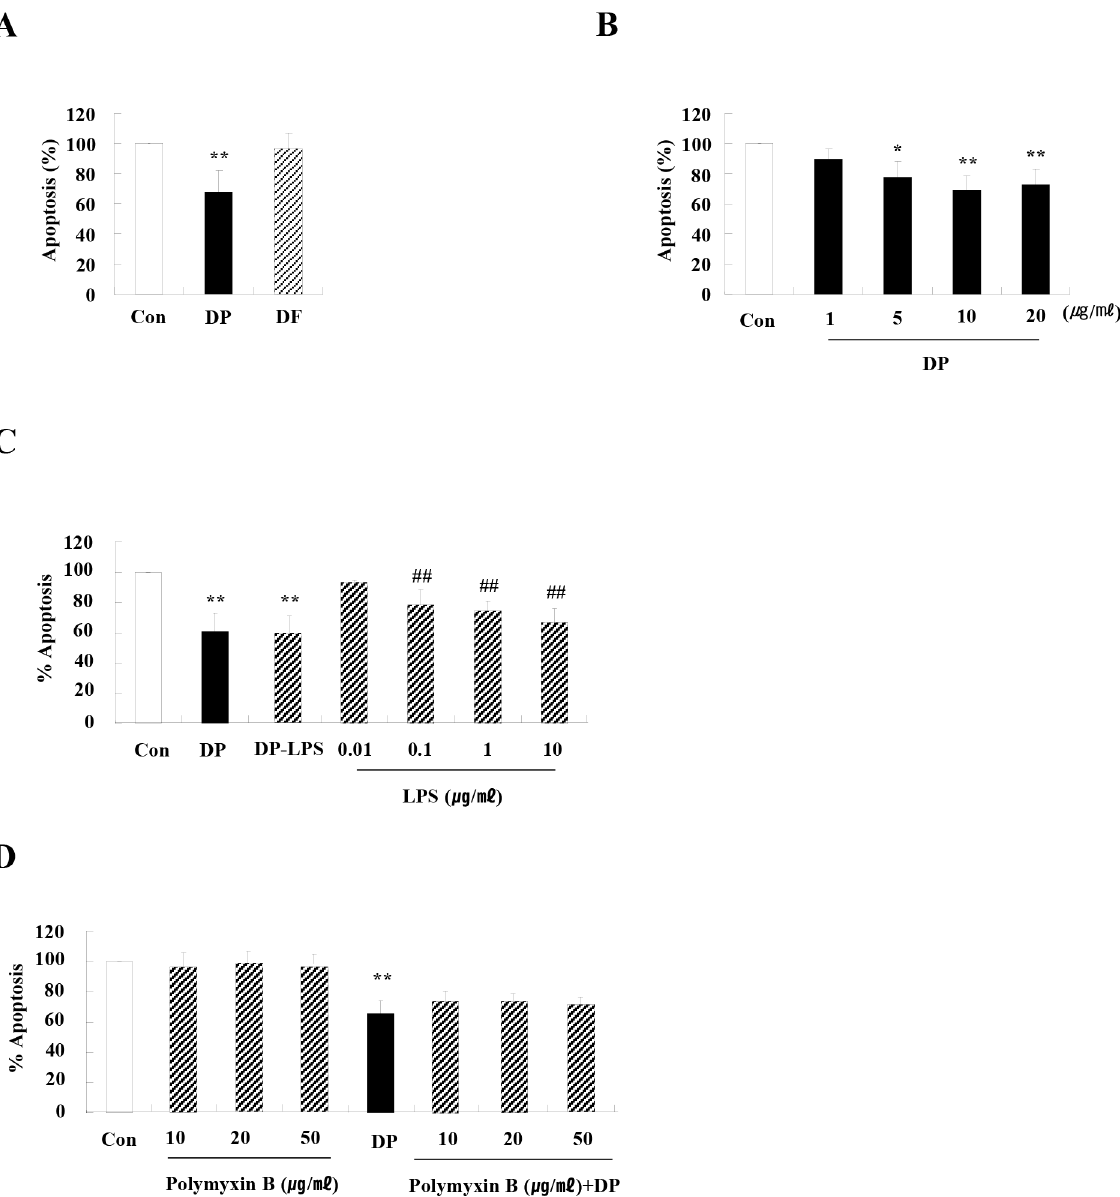
Fig 1. DP delays constitutive neutrophil apoptosis in normal subjects. (A) Neutrophils were isolated from the peripheral blood of normal subjects (n = 59) and then incubated for 24 h in the absence (Con) and presence of DP (10 μ g/mL) and DF (10 μ g/mL). (B) Neutrophils (n = 4) were incubated for 24 h in the absence (Con) and presence of DP in the indicated concentration. (C) Neutrophils (n = 3) were incubated for 24 h in the absence (Con) and presence of DP, DP-LPS [LPS-removed DP using Endo Trap Red (Lonza, MD)], or LPS. (D) Normal neutrophils (n = 3) were pre-treated for 1 h with and without polymyxin B in the indicated concentration, after which the cells were incubated for 24 h in the absence and presence of DP (10 μ g/ml). Apoptosis was analyzed by measuring the binding of annexin V-FITC and PI. Data are expressed as the means ± SD and are presented relative to the control, which was set at 100%. * p < 0.05 and ** p < 0.01 indicate a significant difference between the control and stimulator-treated groups.